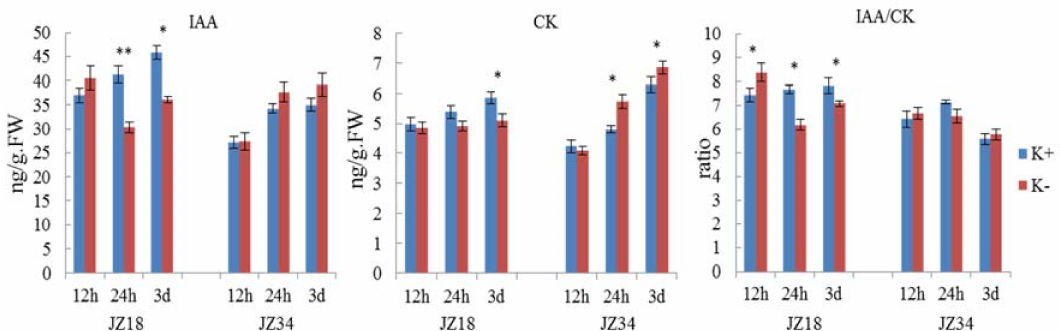
Figure 7. Comparison of the IAA and CK contents and the IAA/CK ratio in the roots of different tomato genotypes under K + -deficiency stress conditions at 12 h, 24 h, and 3 d. K + represents normal K + (4 mM); K − represents K + deficiency (0.5 mM). The experiments were repeated three times. * and ** denote significant differences at p < 0.05 and 0.01.